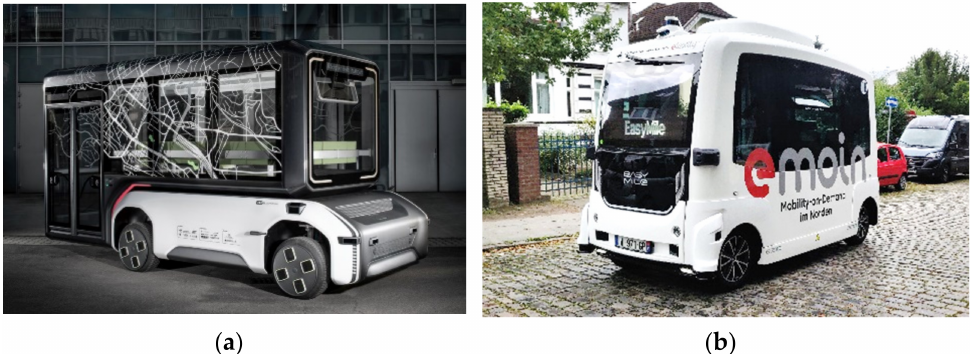
Figure 1. Remotely operated vehicles in investigated projects. ( a ) Modular vehicle concept “U-Shift”. Reprinted with permission from Ref. [19]. 2022, DLR; ( b ) Shuttle “EasyMile” used in real-world transportation laboratory “Reallabor